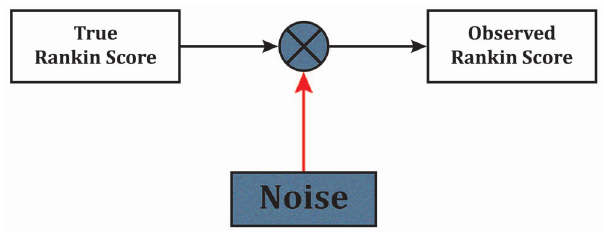
Figure 1. Shannon’s information transmission model adapted to scoring of a patient on the 7 point modified Rankin Scale. A noise or error source is assumed to be in the channel between the sender represented by the ‘True Rankin’ score and the receiver represented by the ‘Observed Rankin’ score.